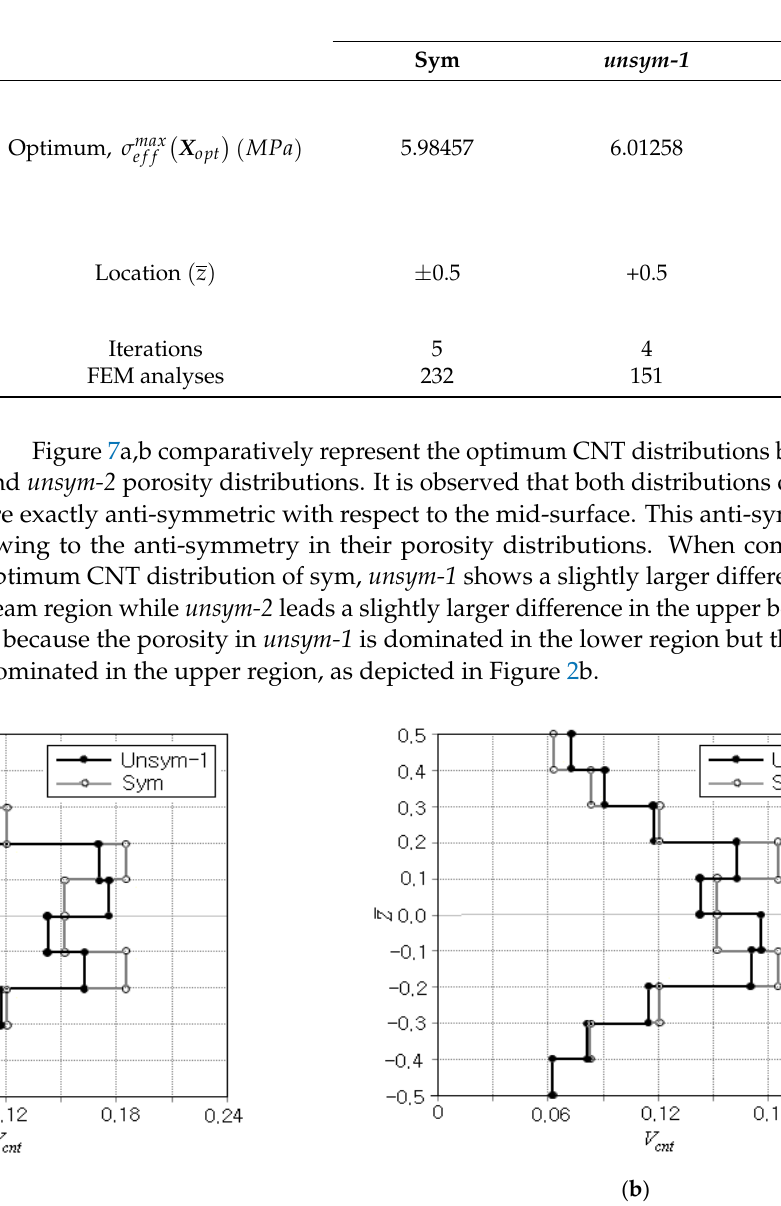
Table 4. The optimization results for three different porosity distributions ( 2 0 . e = ).